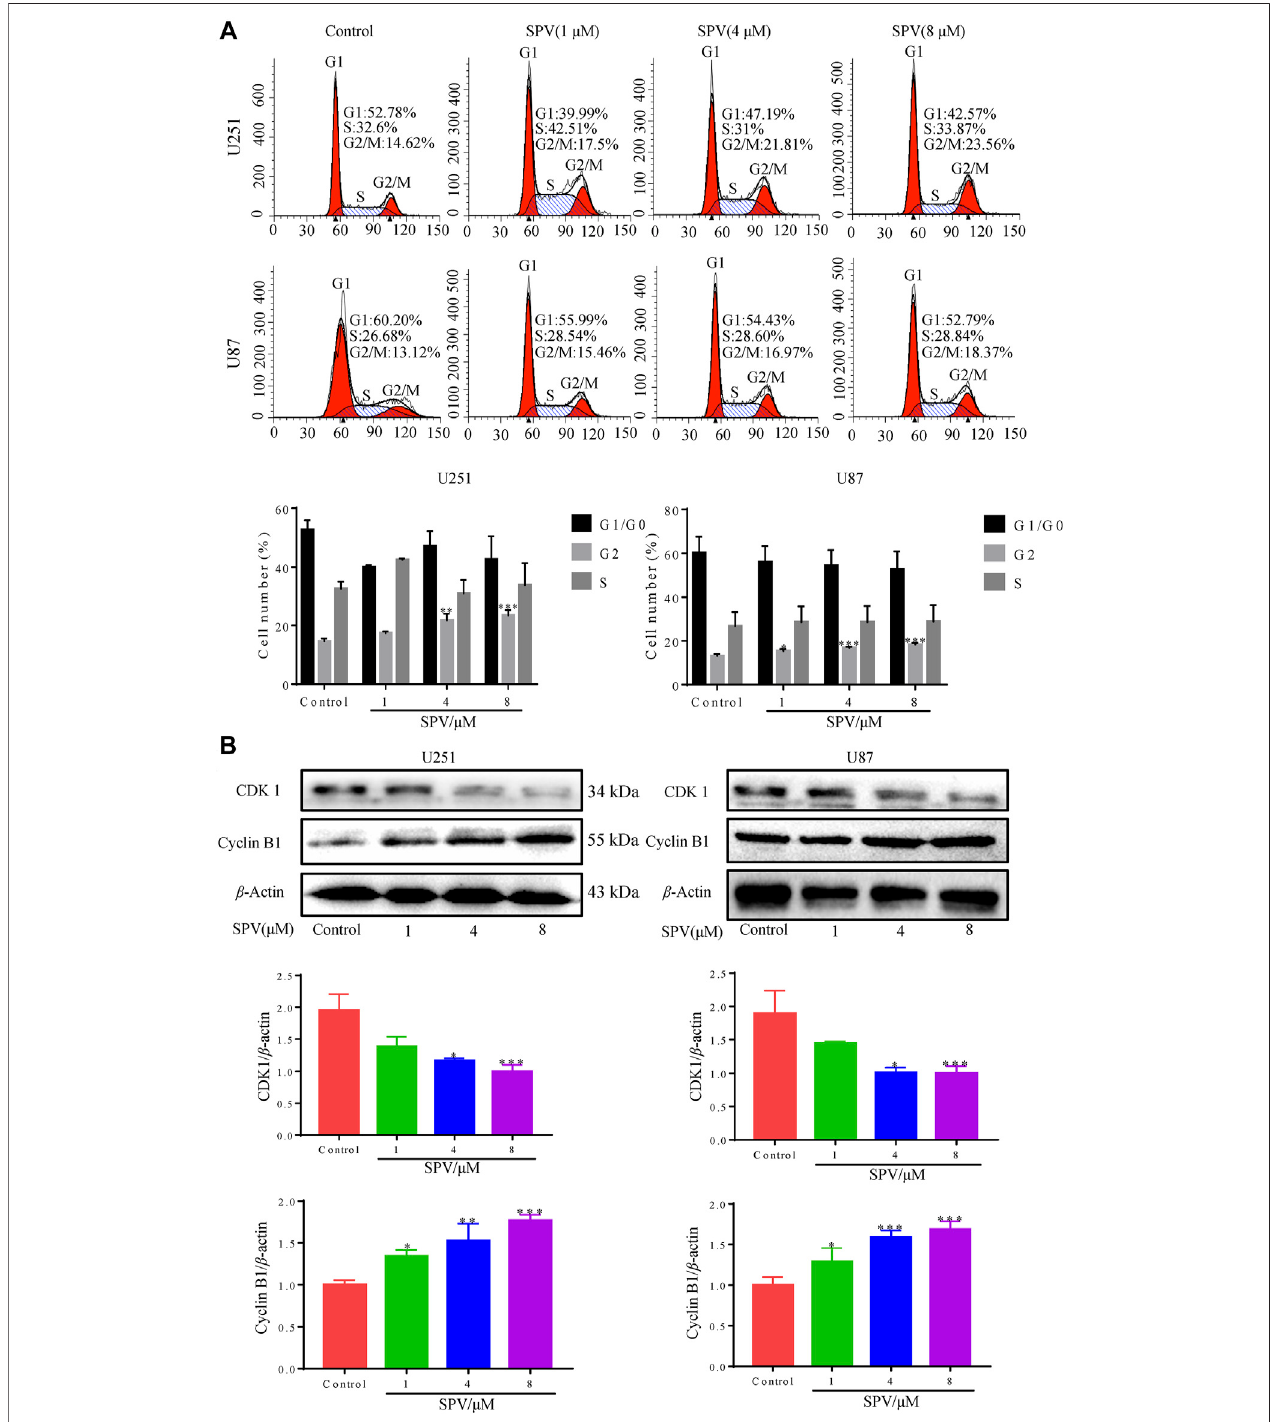
Figure2| SempervirineinducedG2/Mcell cyclearrest inglioma cells. (A) Cells weretreatedwithsempervirine(0, 1,4and 8 μ M) for48 h andcellcycledistribution was analyzed by fl ow cytometry. (B) U251 and U87 cells were treated with sempervirine (0, 1, 4 and 8 μ M) for 48 h. The levels of cell cycle-related protein expressions were determined by Western blotting. Data are presented as the Mean ± SD ( n (cid:2) 3). * p < 0.05, ** p < 0.01 and *** p < 0.001 compared with the control group.